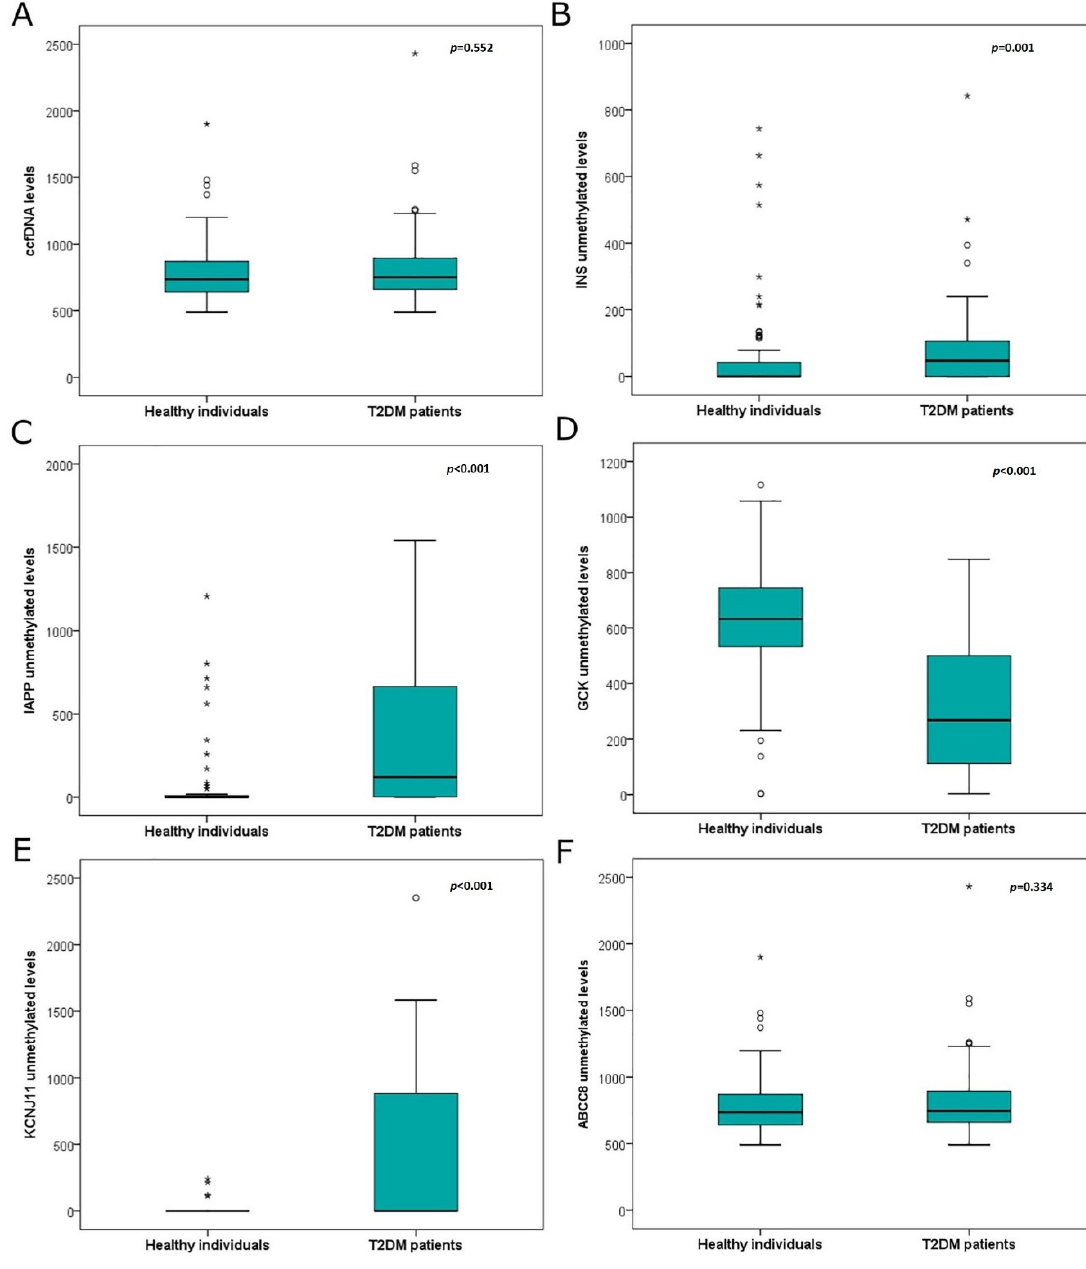
Figure 2. ( A ) Box plot of serum ccfDNA levels between healthy individuals ( n = 71) and T2DM patients ( n = 96) ( p = 0.552). ( B ) Box plot of INS unmethylated alleles between healthy individuals and T2DM patients ( p = 0.001). ( C ) Box plot of IAPP unmethylated alleles between healthy individ- uals and T2DM patients ( p < 0.001). ( D ). Box plot of GCK unmethylated alleles between healthy individuals and T2DM patients ( p < 0.001). ( E ) Box plot of KCNJ11 unmethylated alleles between healthy individuals and T2DM patients ( p < 0.001). ( F ) Box plot of ABCC8 unmethylated alleles between healthy individuals and T2DM patients ( p = 0.534). Small circles (°) correspond to “outlier” values and stars (*) to the “extreme” values of the dataset. Abbreviations: T2DM: Type 2 diabetes mellitus, ccfDNA: circulating cell free DNA.